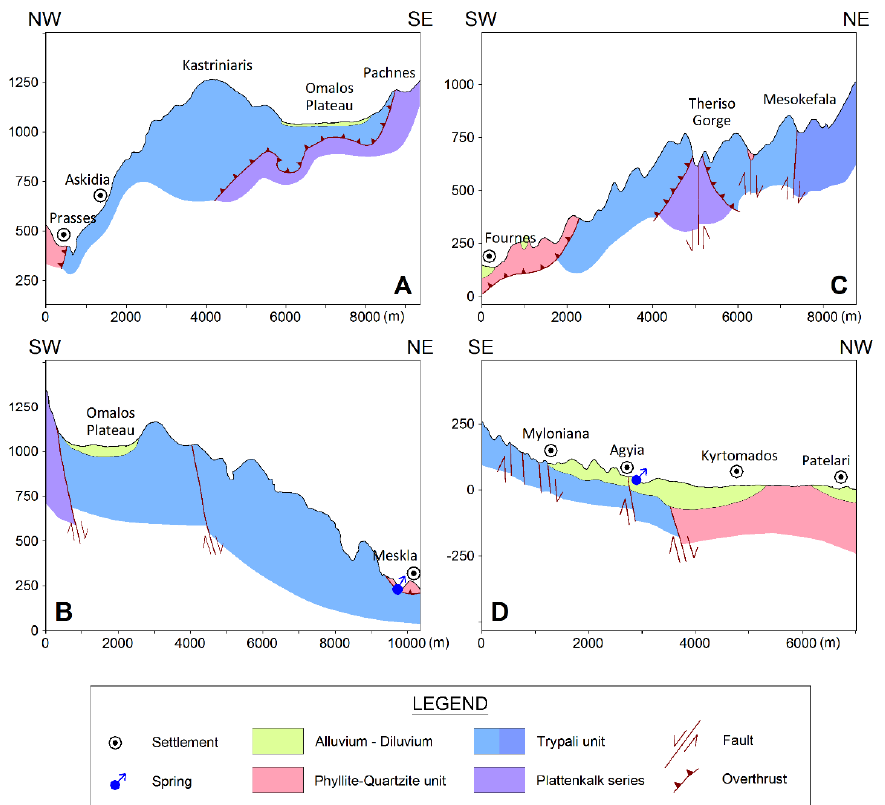
Figure 4. Schematic geological sections. Their locations are defined in Figure 2. ( A ) NW-SE geological cross section through Omalos Plateau, ( B ) SW-NE geological cross section from Omalos to Meskla settlement, ( C ) SW-NE geological cross section across Theriso Gorge, ( D ) Cross section through Myloniana well-field and Agyia’s group springs .